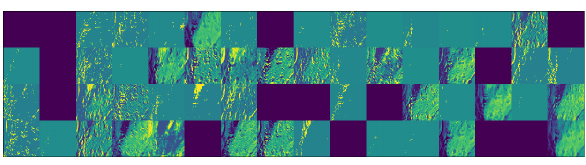
(c) Visualization of second convolution layer using (a) in Figure 5.